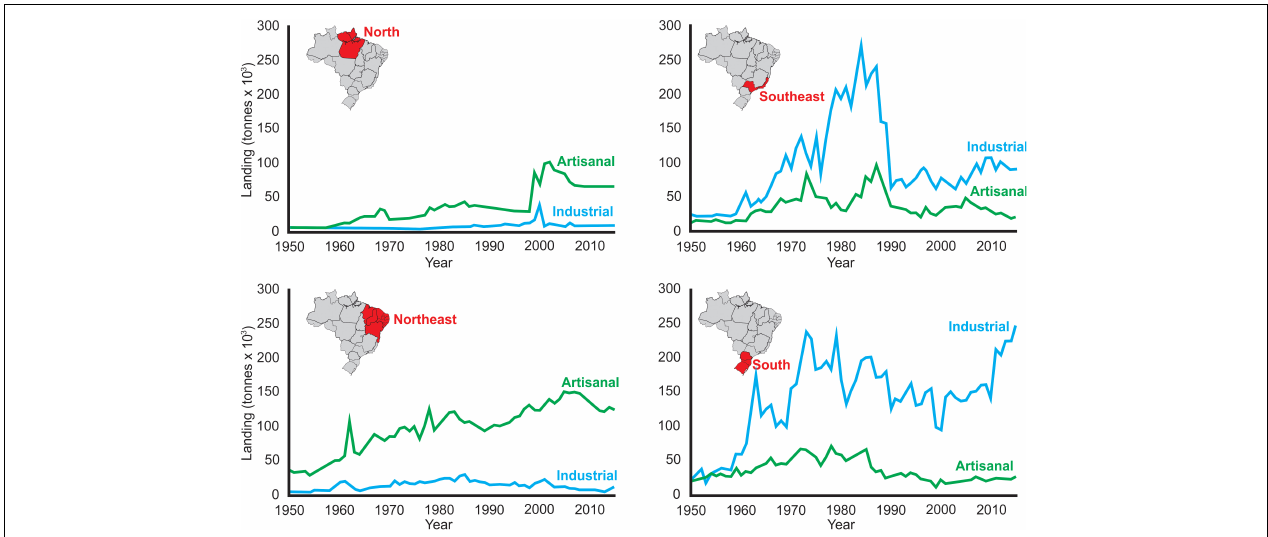
FIGURE 3 | Landing originating from artisanal and industrial fleets in 1950–2015, for the four coastal Brazilian regions: north (states of Amapá and Pará), northeast (Maranhão, Piauí, Ceará, Rio Grande do Norte, Paraíba, Pernambuco, Alagoas, Sergipe, and Bahia), southeast (Espírito Santo, Rio de Janeiro, and São Paulo), and south (Paraná, Santa Catarina, and Rio Grande do